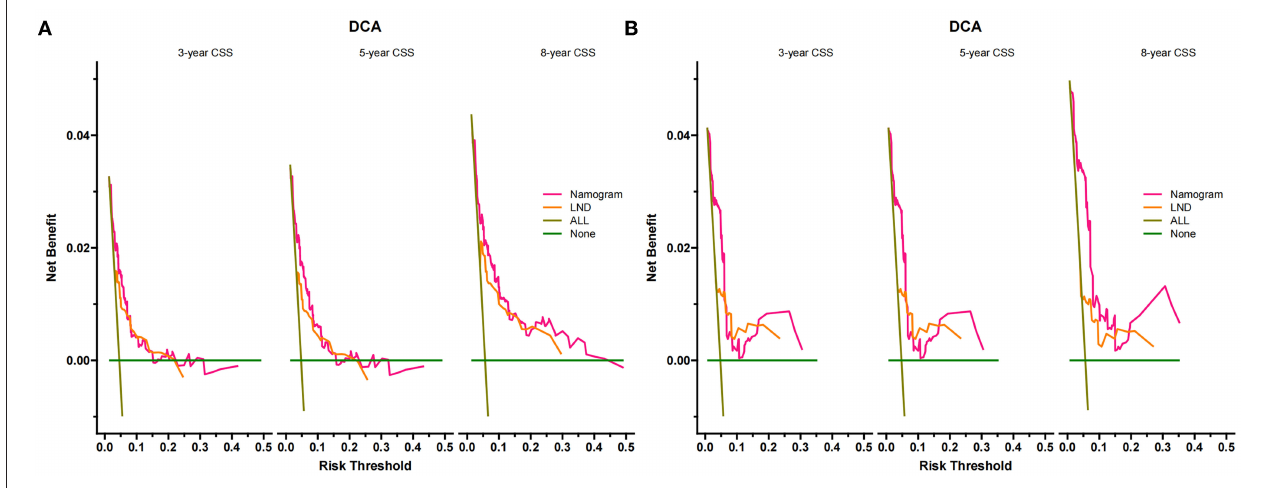
FIGURE 6 | Decision curves of the nomogram predicting CSS in the training cohort (A) and the validation cohort (B) . The x-axis is the threshold probability, and the y-axis is the net income. The green line indicates that no patients have died, and the dark green line indicates that all patients have been killed. When the threshold probability is between 5% and 40%, the net benefit of the model exceeds all deaths or no deaths.